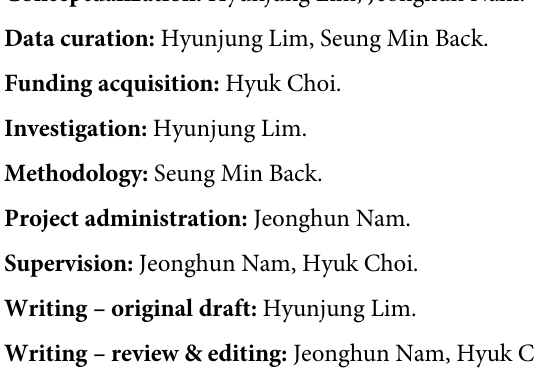
S1 Fig. Schematic of multilayered 3D-PMD device. (a) Exploded view of the 3D-PMD device containing five different layers. (b) Final 3D modelling of the 3D-PMD device. (c) Five differ- ent layers of the 3D-PMD device. S2 Fig. Rotational speed of a 3D-PMD device mounted on a spinning motor depending on the applied